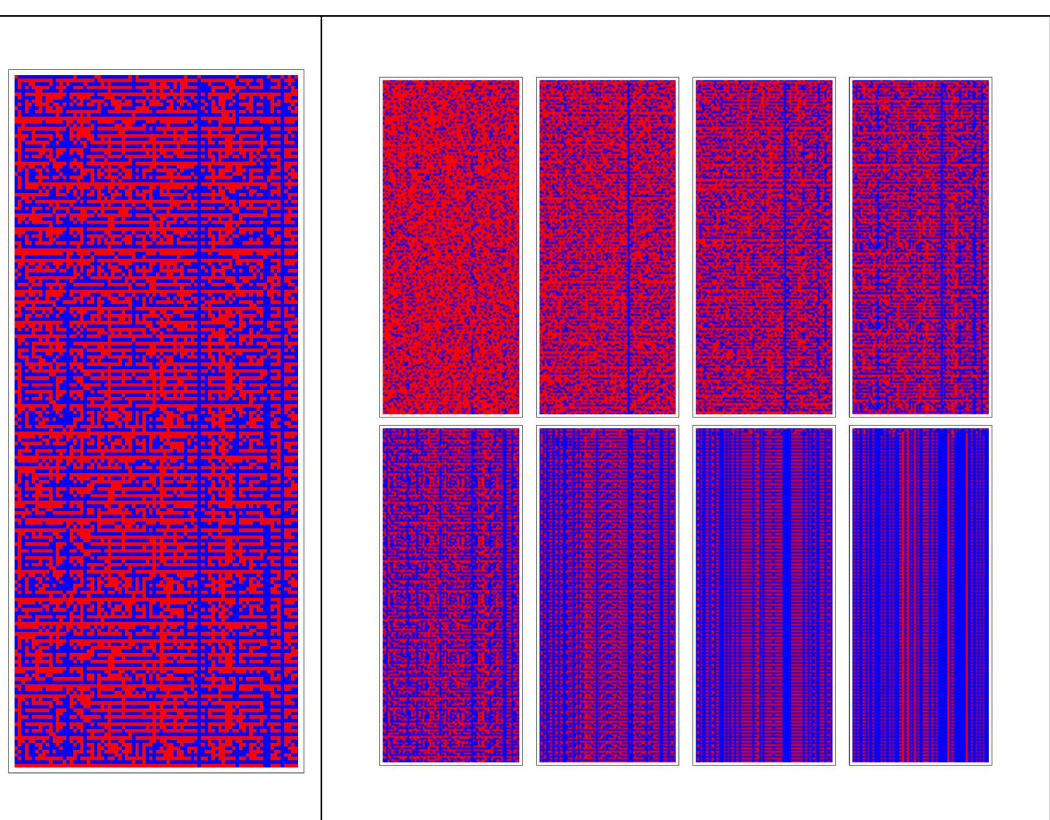
Figure 6. Multiple evolutions of the BN for 200 steps of simulation. This run was attained for parameter b, going from 1 to 8, and a fixed value of a = 1 . As can be seen, the patterns of the BN goes from chaos to order (from left to right), according to the increase of parameter b. The magnified pattern on the left is for b = 4